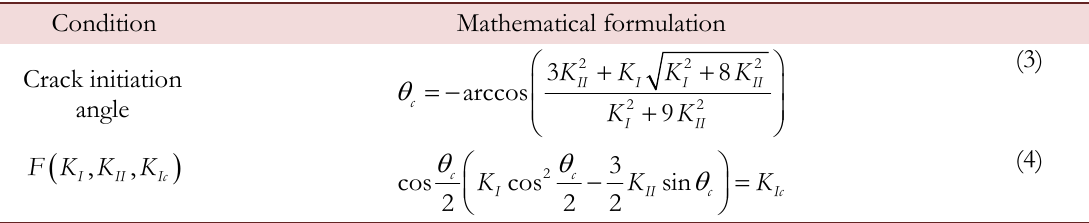
Table 1: The MTS